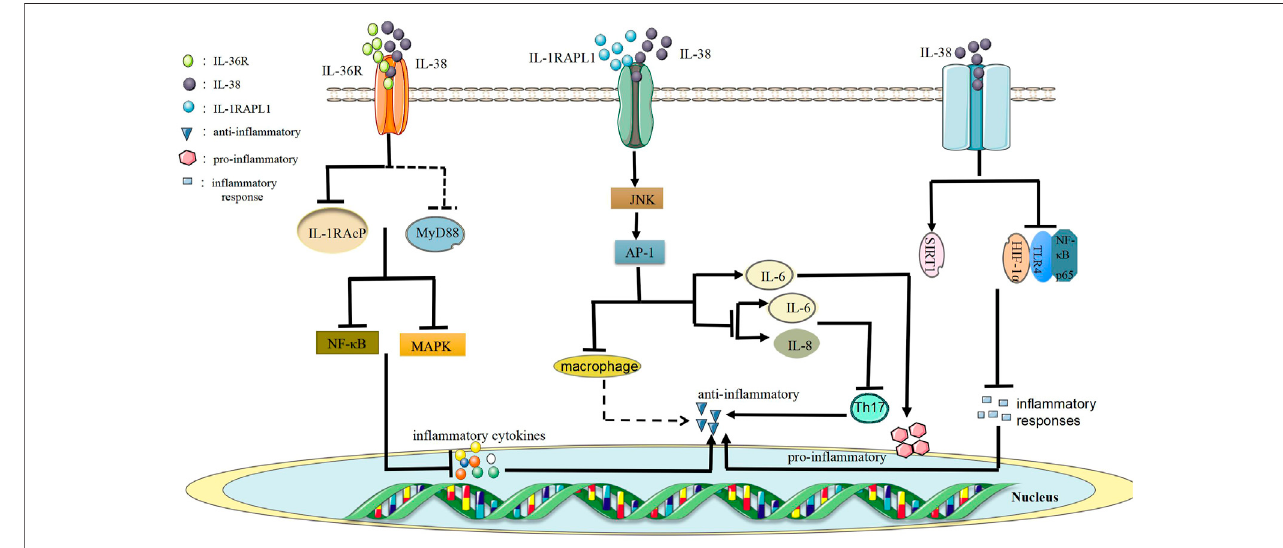
FIGURE 3 | The regulatory role of IL-38 in the autoimmnue